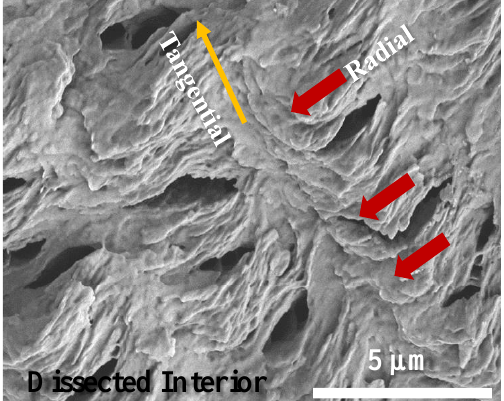
Figure 7. SEM graph of radial-fractured interior of PBA/PEO (90/10) crystallized at 30 °C. Red arrows indicate the zone where radial lamellae sharply bend, twist, and merge into a common tangential line.